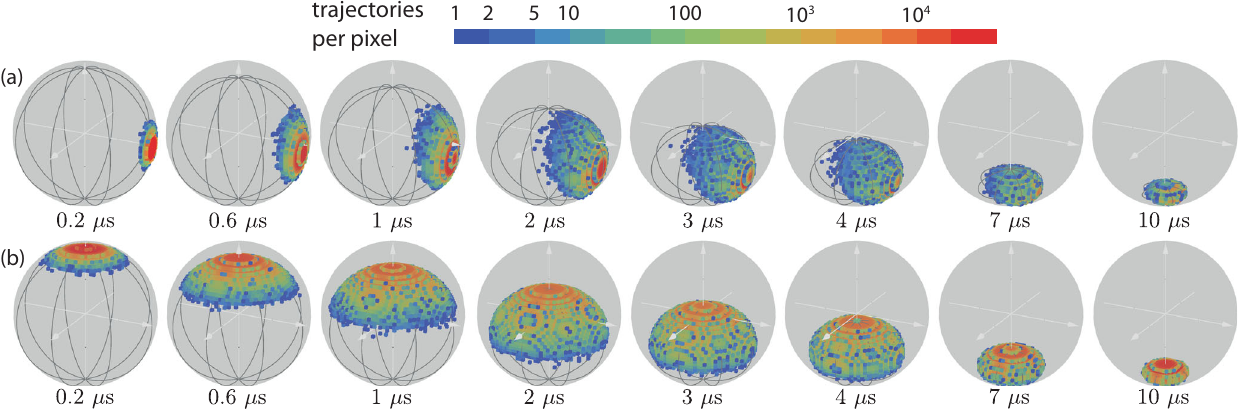
FIG. 4. Statistics of quantum trajectories. Distributions of the qubit states along 10 - μ s-long trajectories for a qubit initially in (a) j þ x i and (b) j e i . The number of trajectories reaching each cubic cell of side 0.04 is encoded in color, out of a total of 3 × 10 6 . White arrows go from − 1 to þ 1 along σ and the Bloch sphere is colored in gray. Meridians of the spheroid spanned by Eq. (5) are also x;y;z